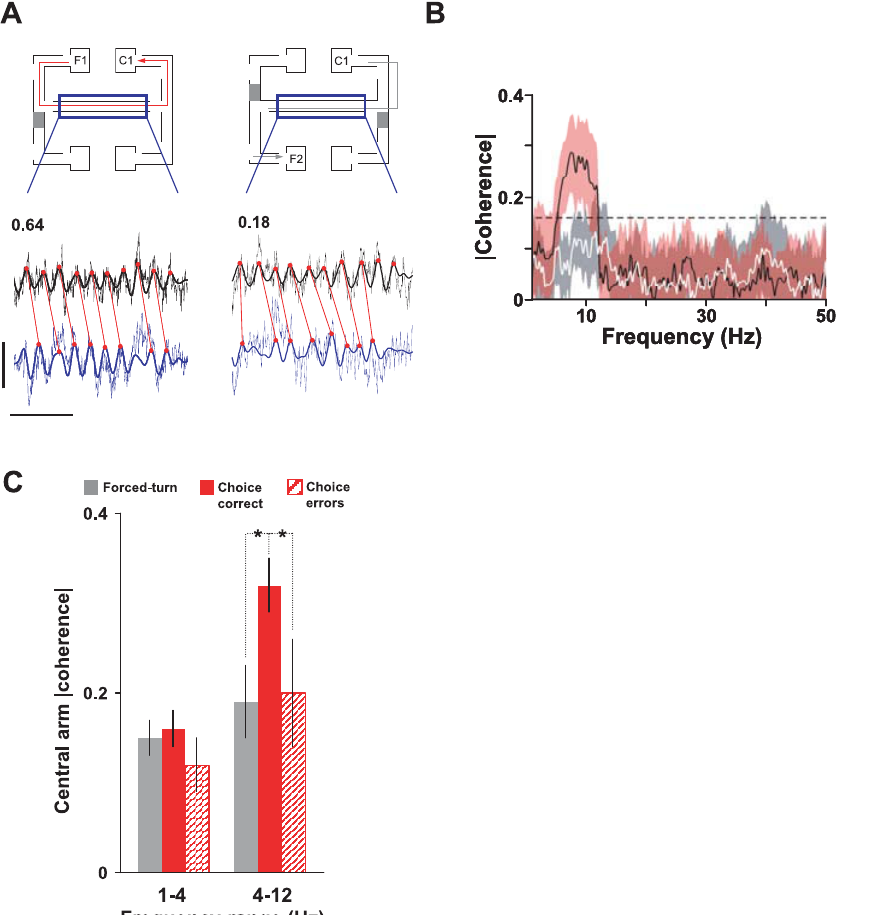
Figure 7. CA1–mPFC LFP Coherence Showed a Significant Peak in the Theta-Frequency Range and Was Enhanced during Choice Epochs (A) Raw LFP from dorsal CA1 (black) and mPFC (blue) during consecutive single central-arm crossings in the choice (left) and forced-turn (right) directions. Thick lines show theta-filtered LFP. Horizontal scale bar 0.5 s; vertical scale bar 0.8 mV. Red lines highlight the timing relationship between CA1 and mPFC theta peaks (red circles). Numbers above raw LFP traces give coherence in the 4- to 12-Hz range during these two example trials. (B) Trial-averaged, central-arm coherence during a single run-session (17 trials). Central-arm coherence is subdivided into forced-turn (grey) and choice (red) directions. Dashed line marks 95% confidence level, with shaded band thickness corresponding to jackknife error bars (estimated over trials and nine tapers). Significant coherence was seen only in the theta-frequency range, and only during choice epochs on the central arm. (C) Mean coherence at delta (1–4 Hz) and theta (4–12 Hz) frequencies, pooled across animals during forced-turn (grey), choice-correct (red), and choice- error (hatched red) epochs (* p , 0.05). Like theta CA1–mPFC spike cross-correlations and theta phase-locking of mPFC units, theta-frequency CA1– mPFC LFP coherence peaked during choice-direction runs across the central arm. DOI: 10.1371/journal.pbio.0030402.g007